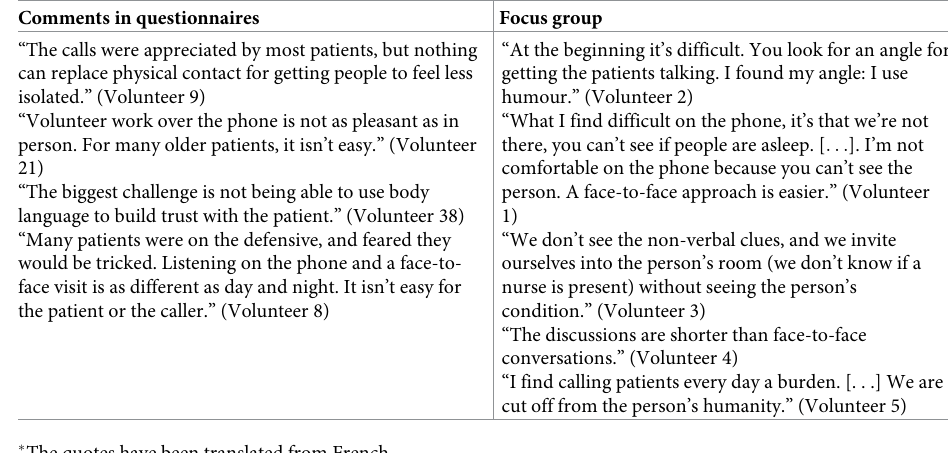
Table 2. Feedback from volunteers on the limits of courtesy phone calls �